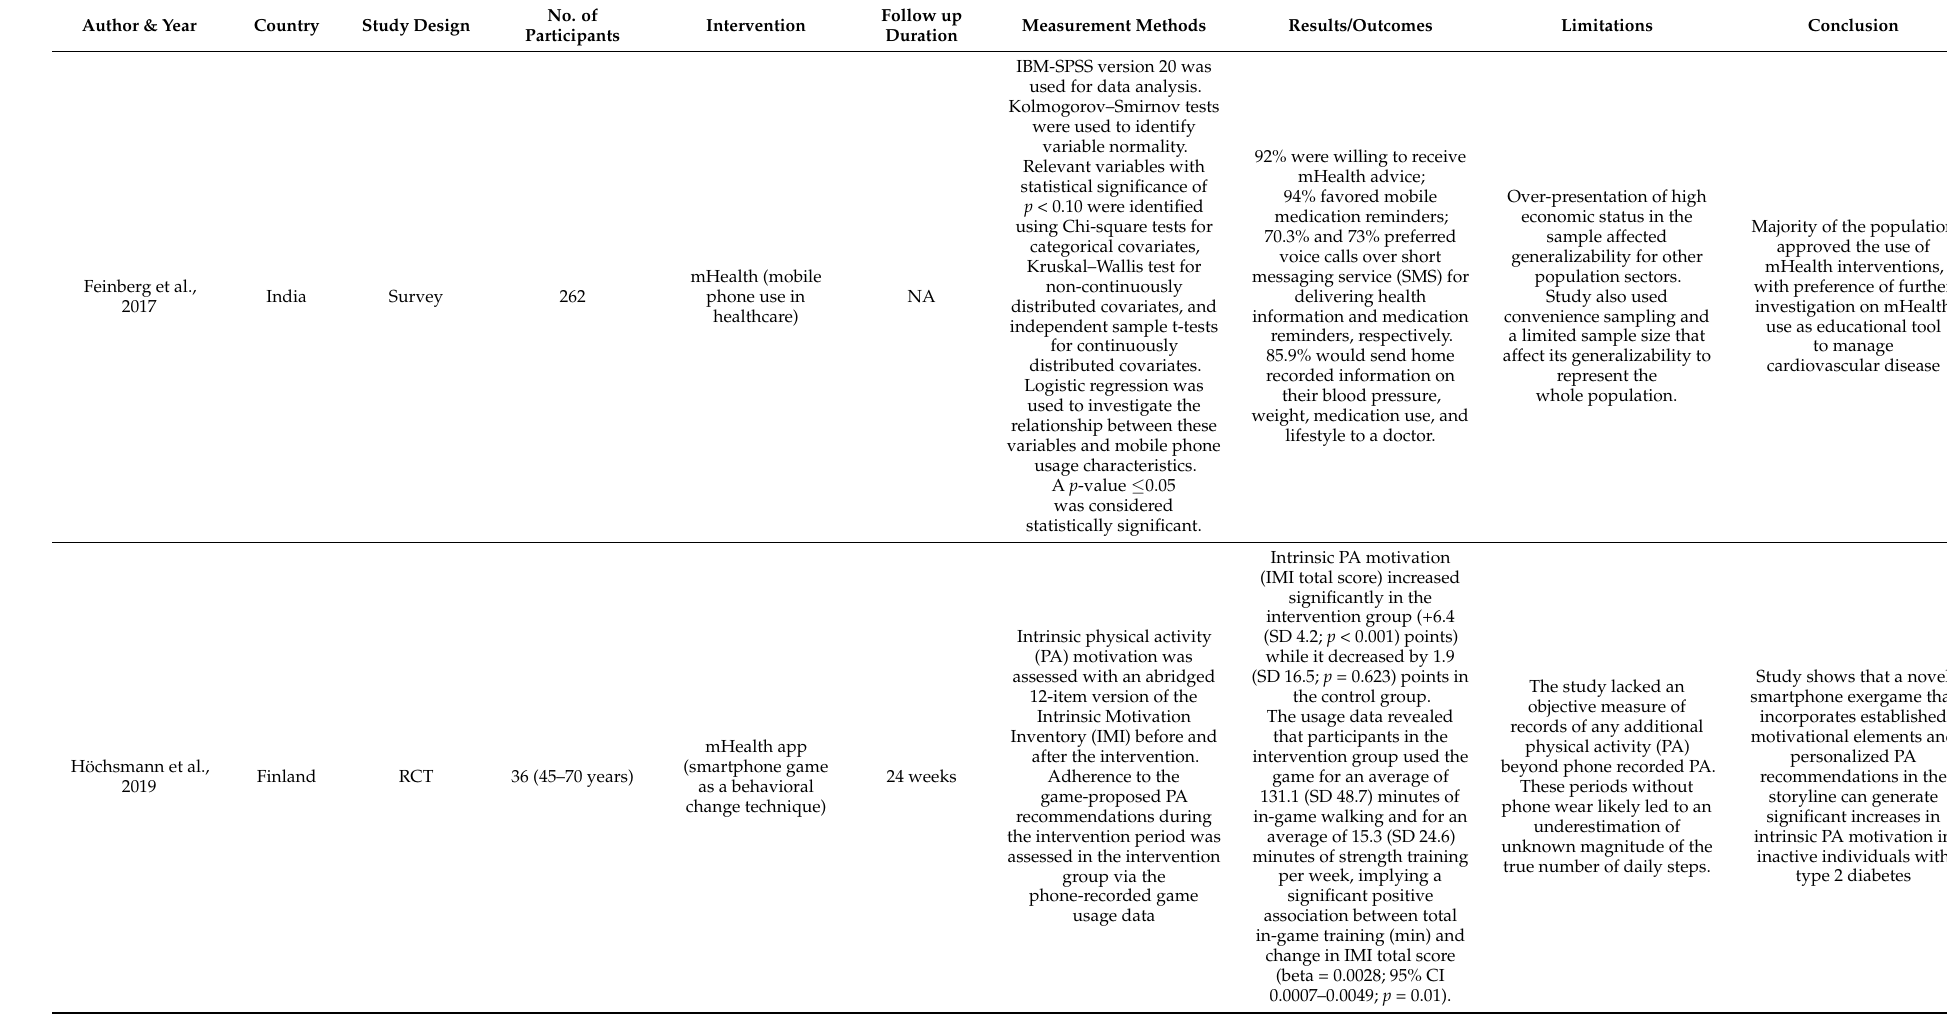
Table 1. Characteristics of included